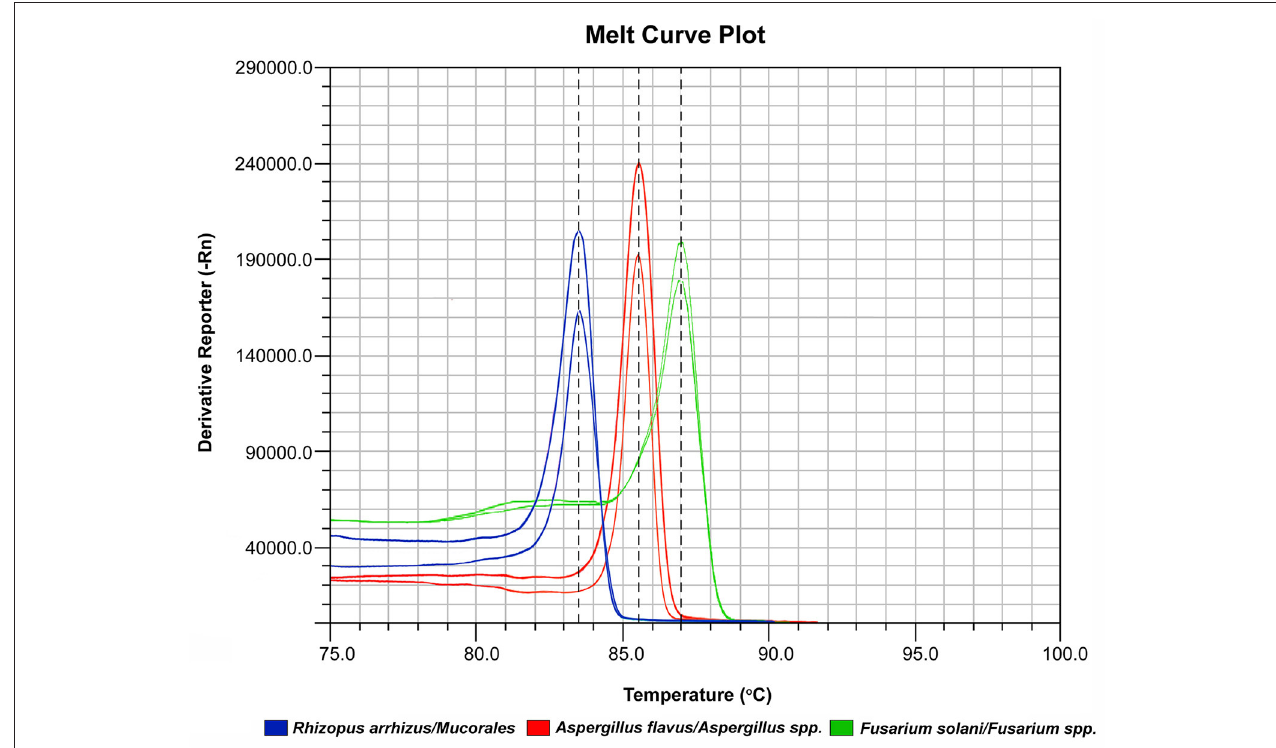
FIGURE 2 | Variation in melt curve profile of different